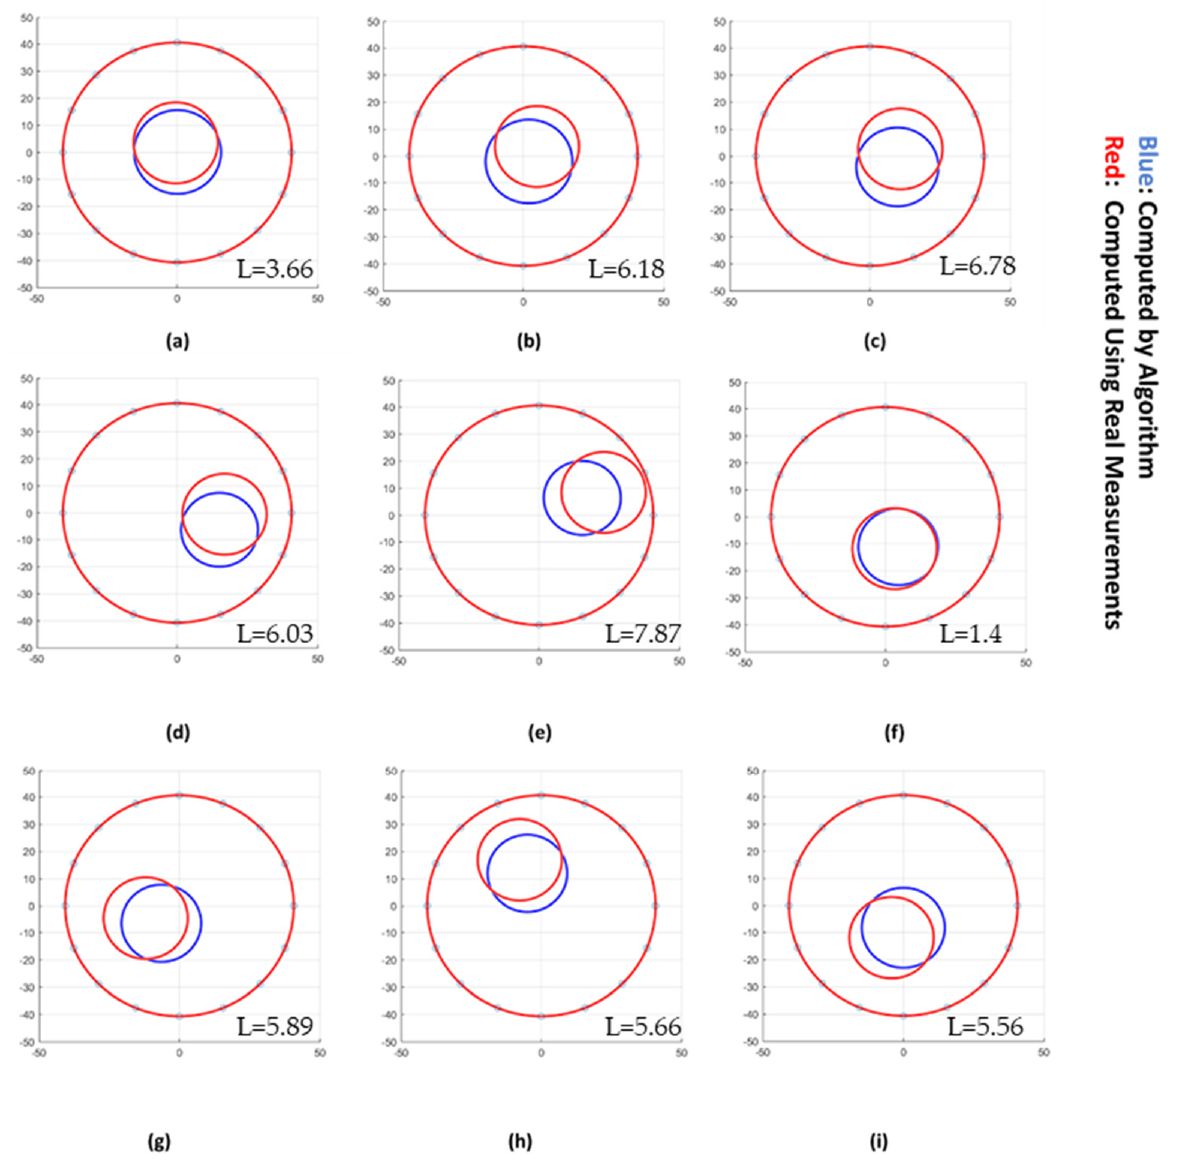
Figure 11. Comparison between the algorithm reconstruction (blue circles) and the real phantom characteristics measured using a ruler (red circle) for the point C to P8 ( a – i ) for the 30 mm diameter phantom. L values (mm) are also inserted in each figure.